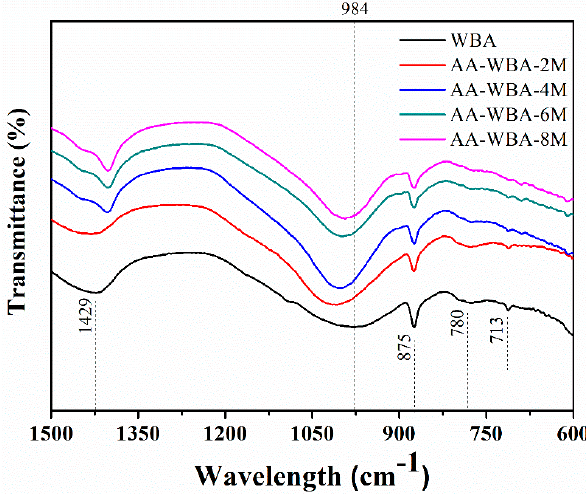
Figure 7. WBA and AA-WBA FTIR spectra.